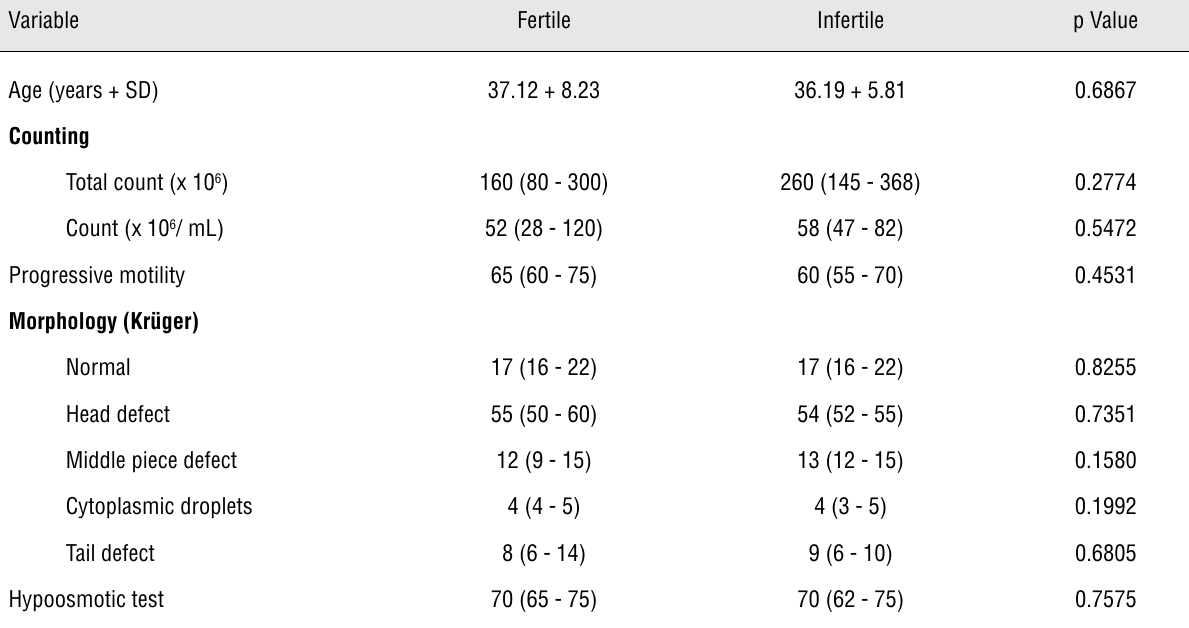
Table 1 - Fresh sperm